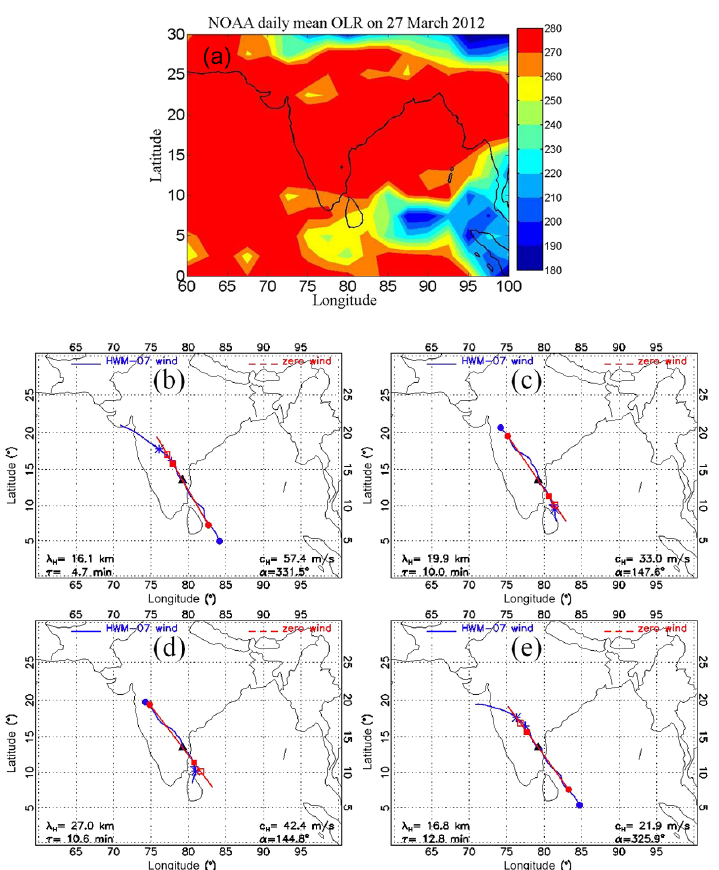
Figure 8. Daily mean OLR data (a) and ray paths for the different wave events of 27 March 2012 (b–e) . Blue (red) lines are for model winds (zero winds). Gadanki location is black triangle in (b–e) . Plus and filled square symbols indicate where the gravity waves have the maximum amplitude into the thermophere. Star and open square show where/when the gravity waves have less than 1% of their initial amplitude.